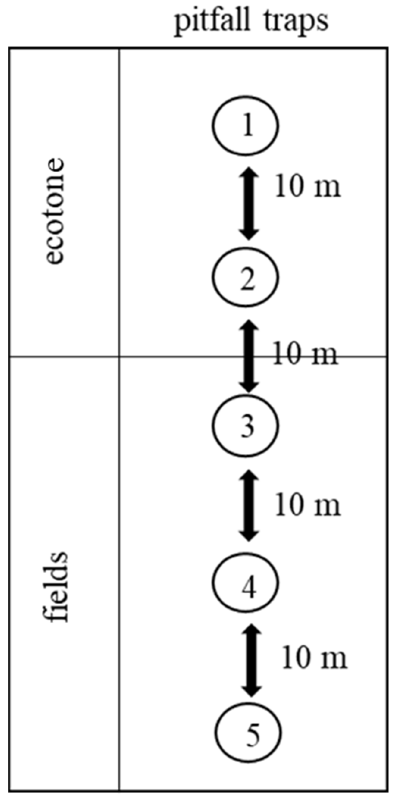
Figure 2. Diagram of the sites of pitfall traps.